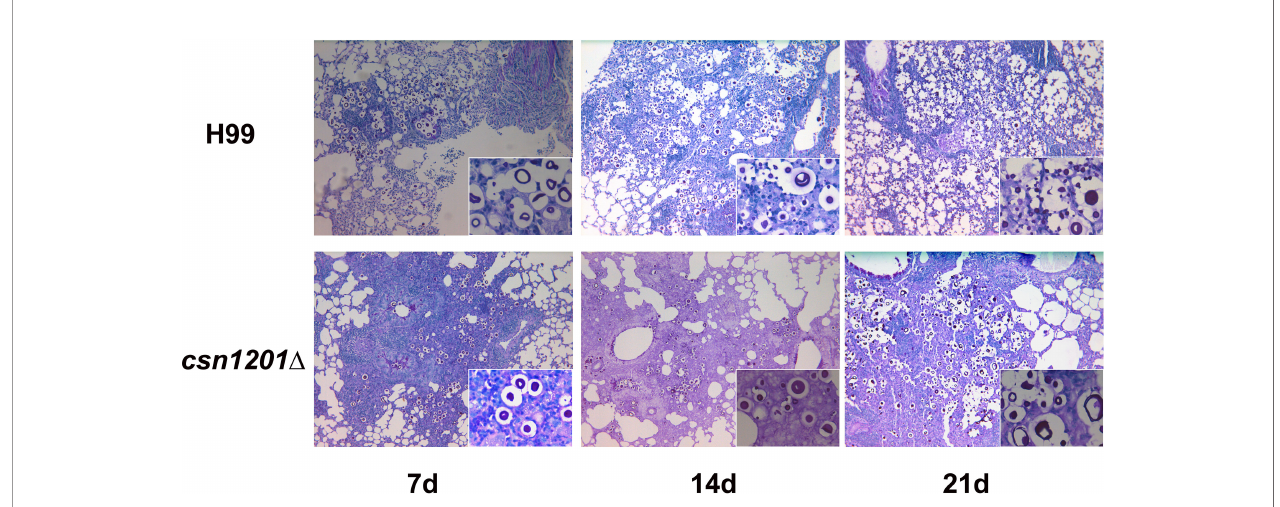
FIGURE 7 | Csn1201 regulates host pulmonary in fl ammatory responses to C. neoformans . Representative photographs of haematoxylin and eosin-stained mouse lungs at different times